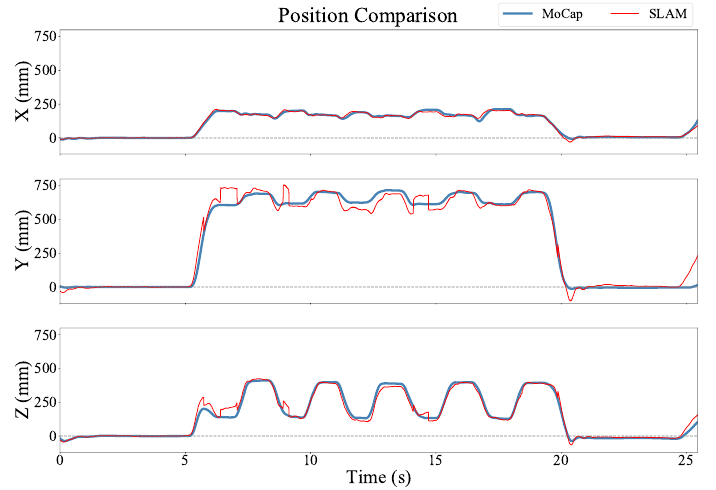
Figure 5. Position versus time for each axis in the Optical Motion Analysis Lab coordinate frame. The two estimates were in strong agreement, but the SLAM estimate included